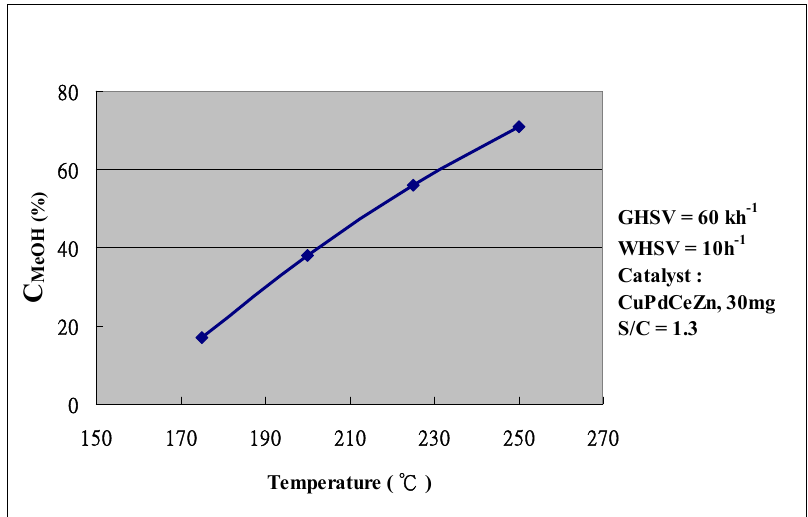
Figure 6. Relative curve of conversion and temperature under the SRM reaction.